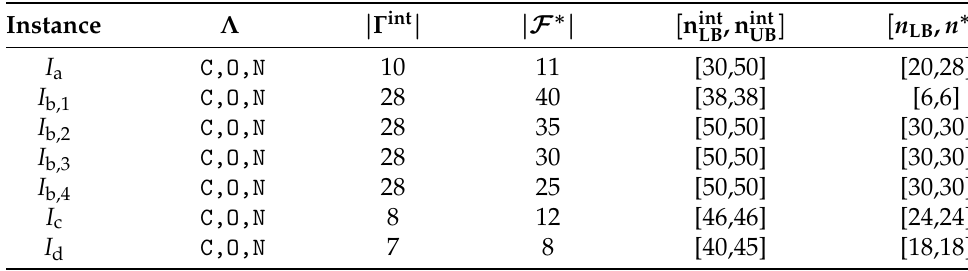
Table 6. Features of test